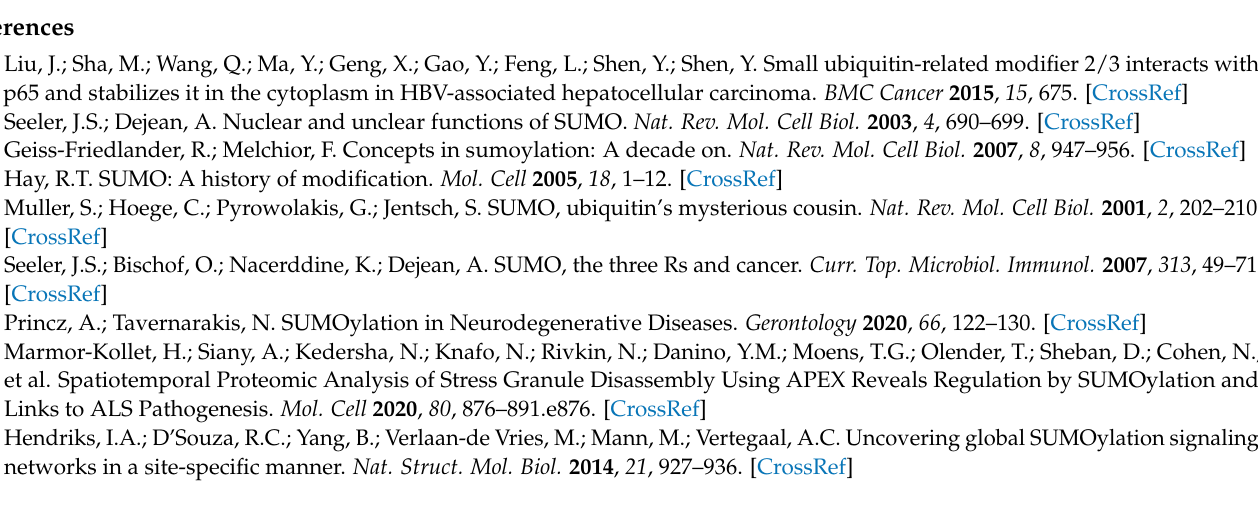
Table S6: Performances of different models for predicting SUMOylation sites on the independent test; Table S7: Performance comparison of the original models and reproduced models; Table S8: The performances of the reproduced models on our independent test